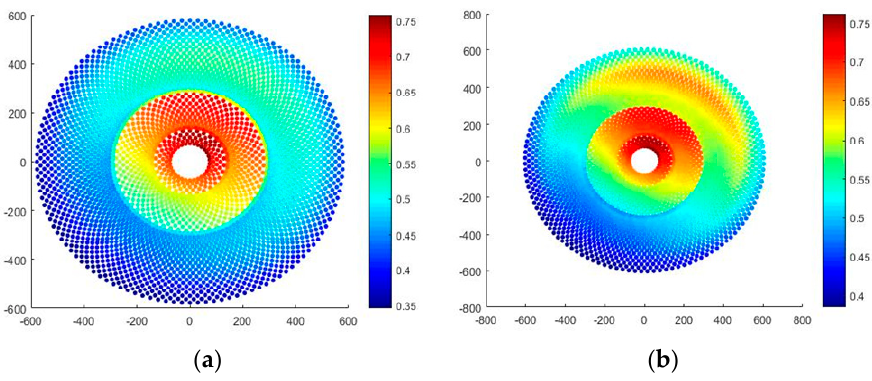
Figure 5. The contours of the annual averaged efficiency of heliostat field: ( a ) un-optimized result and ( b ) optimized result.